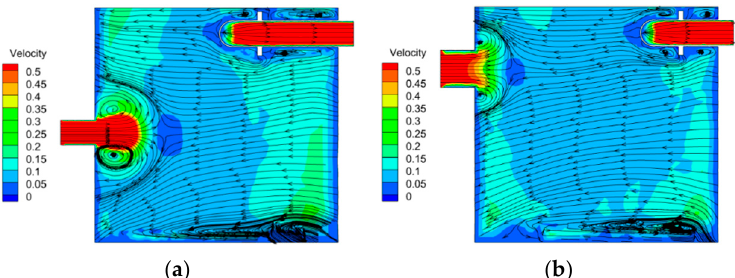
Figure 12. Streamline and velocity distribution of N3 section before and after optimization. ( a ) Before optimization. ( b ) After optimization.